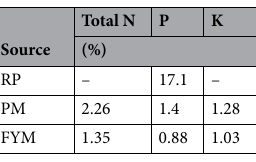
Table 8. NPK composition of P sources. RP, PM and FYM stands for rock phosphate, poultry manure and farm yard